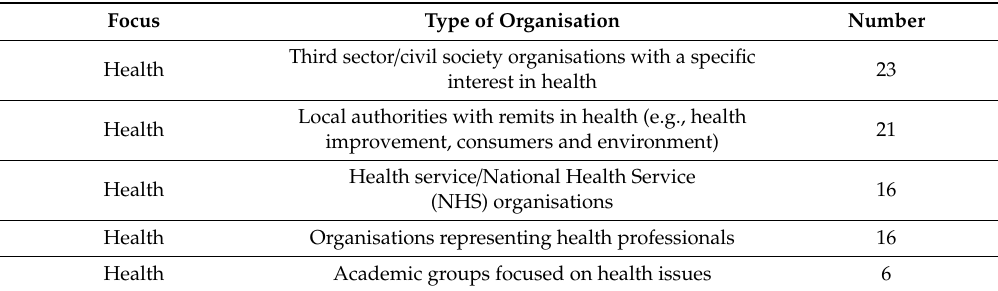
Table 2. Actors who submitted responses to the consultation process.